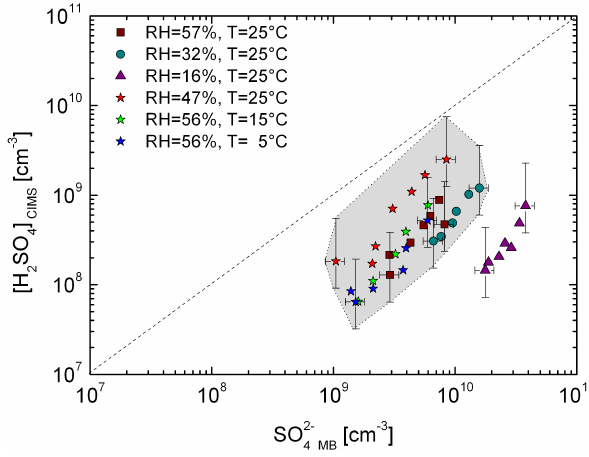
Fig. 4. Monomer to dimer ratio as a function of three different nucleation temperatures T =5, 15 and 25 ◦ C.